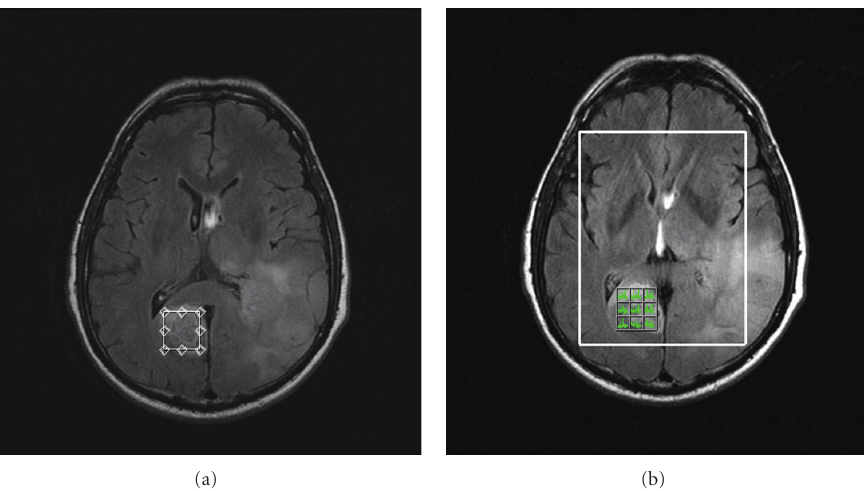
Figure 1: Intratumoral voxel prescription during SV (a) and 2D-MRSI (b) scan techniques, in a 77-year-old woman with a glioblastoma. For the two scan techniques, the voxel of interest has been placed in similar